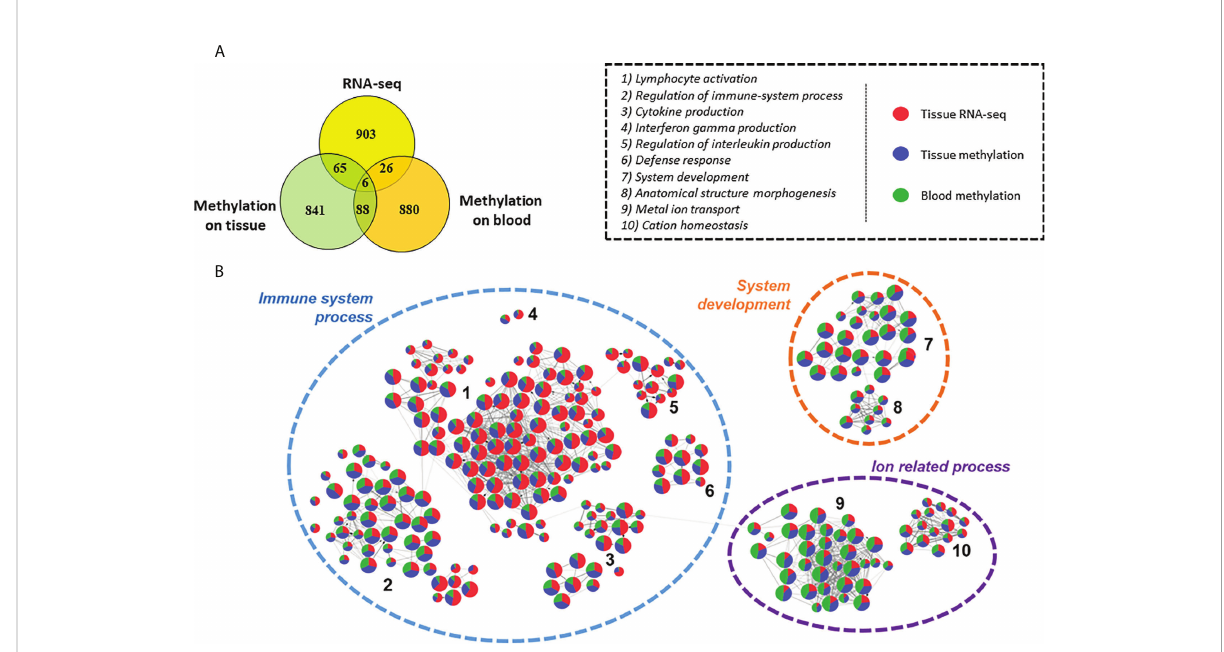
FIGURE 8 Comparison of differentially expressed genes, genes affected by methylation in tissue dataset and genes affected by methylation in blood dataset. (A) Venn diagram of top 1000 genes differentially expressed or methylated in previous tissue RNA-seq, tissue DNA methylation and blood DNA methylation analysis between control/asymptomatic and severe CCC samples. (B) Graph of the Gene ontology Biological Processes analysis of dysregulated element between control/asymptomatic and severe CCC. Nodes represents biological processes terms and are divided in 3 colors, according to the proportion of genes from RNA-seq (red), tissue methylation (blue) or blood methylation (green) analysis. Edges in the graph link GO terms having gene in common. 3 principal terms are highlighted in this synthesis. More precisely, several groups of gene ontology are enriched, involved in biological process related to: 1) lymphocyte activation; 2) Regulation of immune-system process; 3) Cytokine production; 4) Interferon gamma production; 5) Regulation of interleukin production; 6) Defense response; 7) System development; 8) Anatomical structure morphogenesis; 9) Metal ion transport; 10) Cation